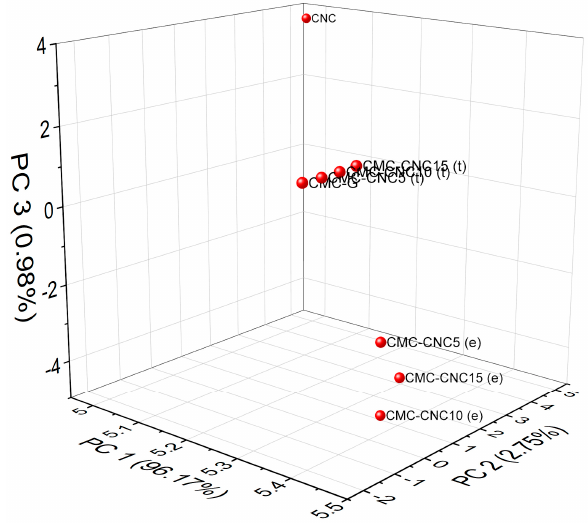
Figure 4. PC scores plot of the experimental and theoretic data.